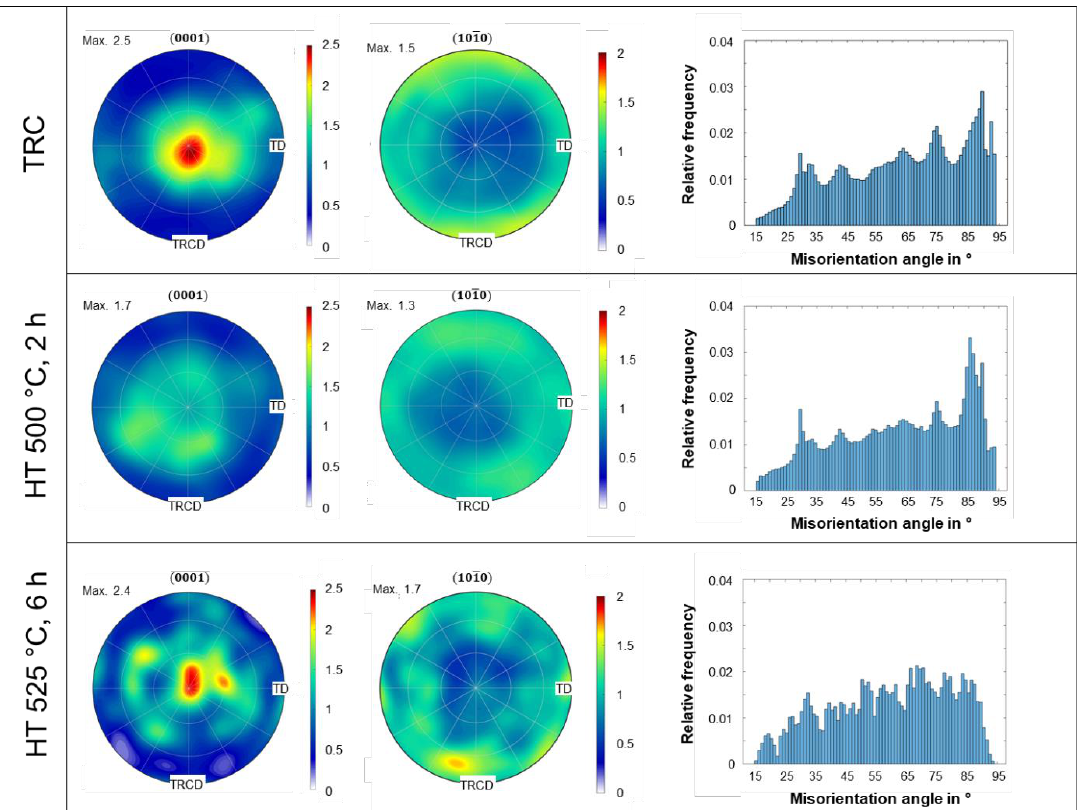
Figure 7. (0001) and (10 1̅ 0) pole figures and misorientation angle distribution of the twin-roll cast and the heat-treated conditions.